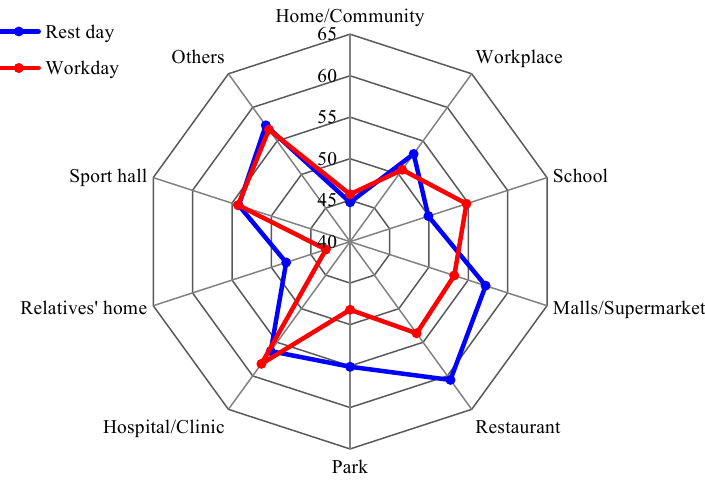
Figure 8. Noise exposure under different activity places on workday and weekend.